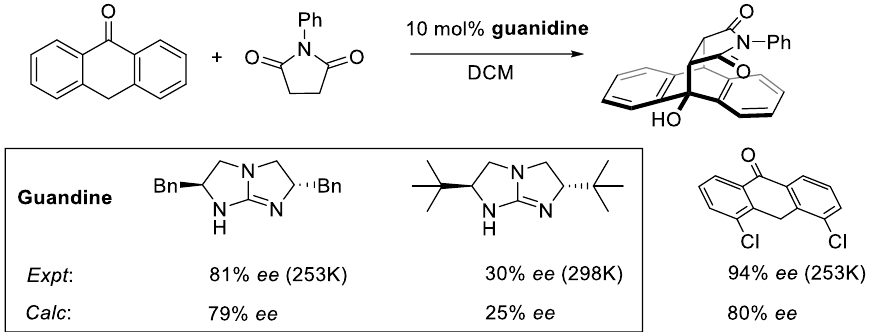
Figure 24. Bicyclic guanidine catalyzed cycloaddition [186]. Values are from the work of Kee and Wong [32]. % ee are calculated from ΔΔ G ‡ at CPCM(DCM)/DSD-PBE95-D3(BJ)/def2-QZVP//PBEh- 3c as reported by the cited reference.